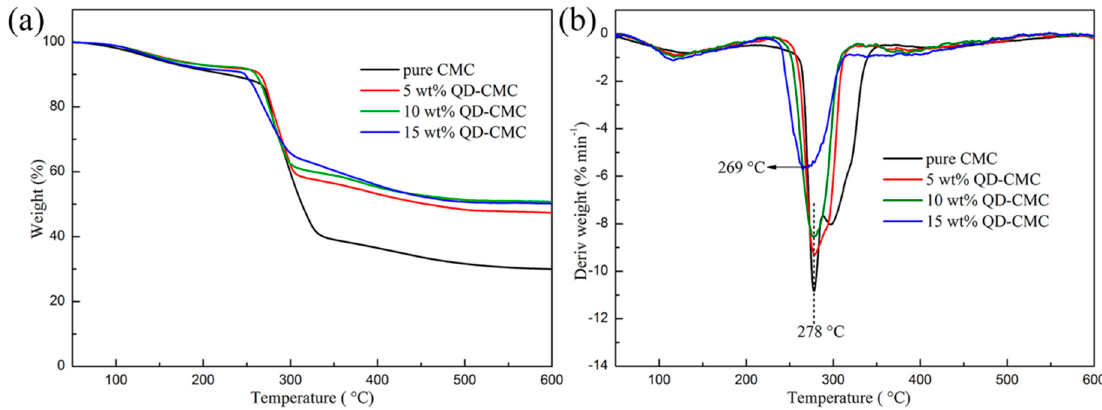
Figure 5. Thermogravimetric analysis (TGA) and differential thermogravimetry (DTG) curves of CMC and composites, ( a ) TGA curves; and ( b ) DTG curves.